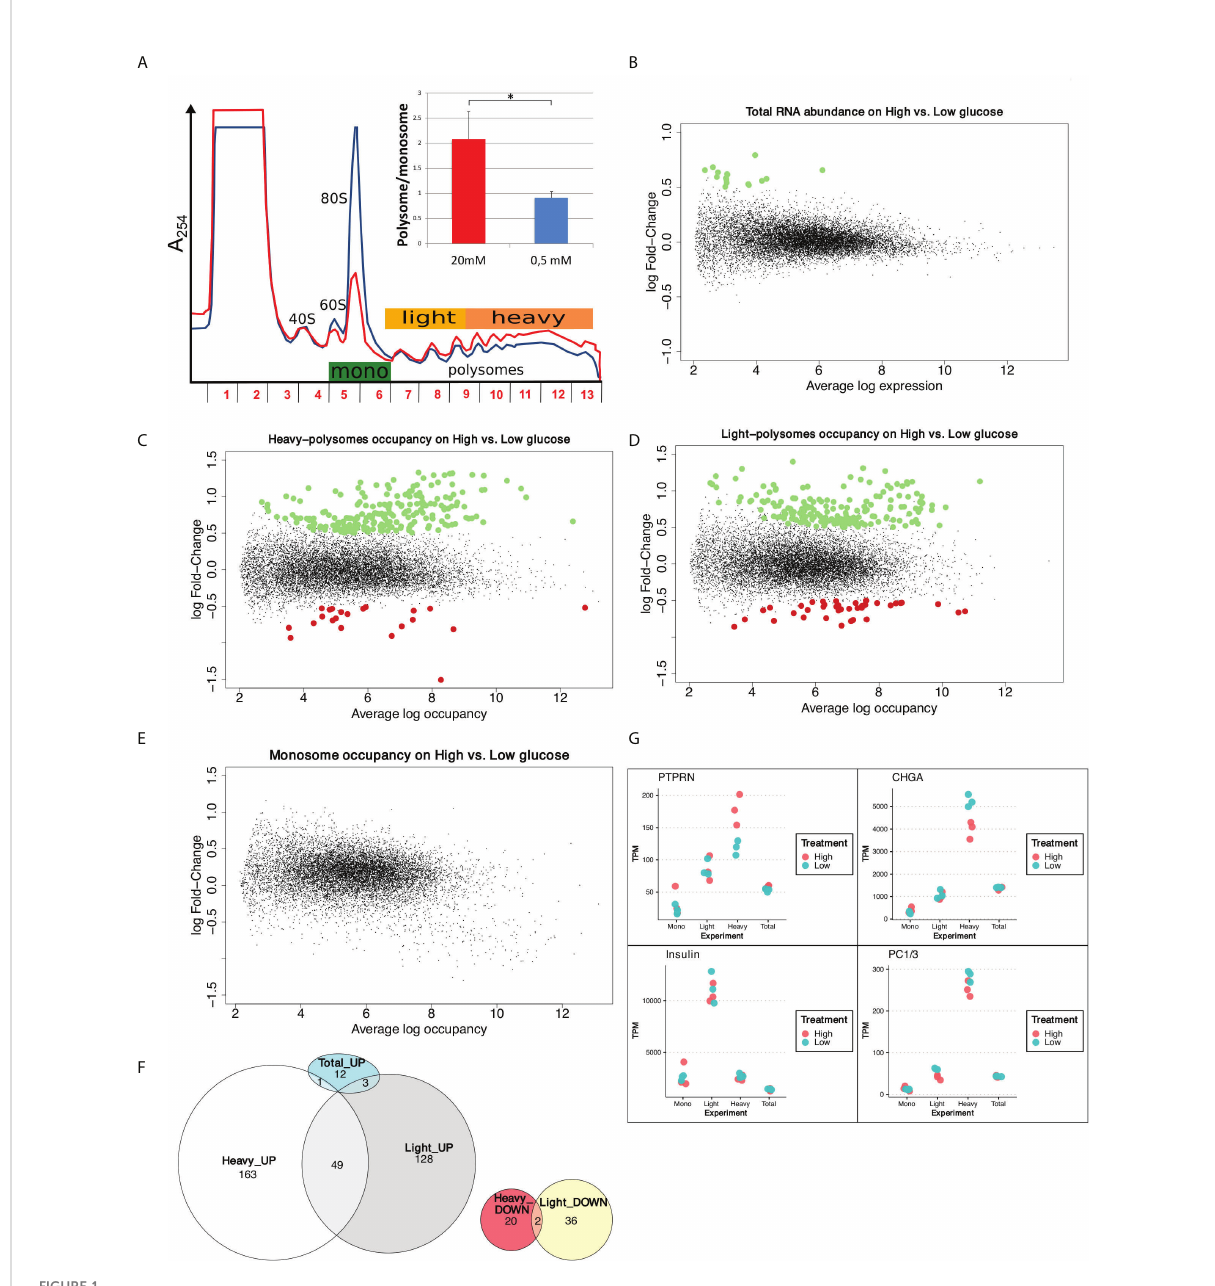
FIGURE 1 Glucose induces increase in protein synthesis without affecting mRNA abundance and regulates translation rates of a subset of mRNAs. (A) Polysome pro fi les of EndoC- b H2 with Low glucose (blue) and High glucose (red). The absorbance at 254nm (A254) recorded during the collection of the fractions of the gradient is displayed. The positions of 40S, 60S, 80S and polysomes are indicated. The tree-colored bars represent the fractions that were pooled for sequencing: monosomes (green), light polysomes (yellow), heavy polysomes (light orange). EndoC- b H2 cells in high glucose had a signi fi cantly higher polysome/monosome ratio than did EndoC- b H2 cells in low glucose. Cells were treated in parallel using paired culture plates, and centrifugated together in the same rotor. Figure shows a representative replicate. The statistical signi fi cance of the polysome/monosome ratio was assessed using a paired t-test from three independent experiments (*p < 0.001, n = 3). (B) MA-plot of total mRNA abundance, dots in green specify up-regulation. (C – E) . MA-plots for each pool of fractions: heavy polysomes (C) , light polysomes (D) and monosomes (E) ; dots in green corresponds to transcripts that are upregulated upon glucose stimulation, dots in red to transcripts that are downregulated. (F) Venn diagram showing the overlap between glucose UP- or DOWN- regulated transcripts in Light and Heavy polysomes. Total_UP are transcripts varying in abundance. (G) TPM values for each condition and each replicate are plotted. In red High glucose replicates, while in cyan Low glucose replicates. Names of the plotted gene is indicated